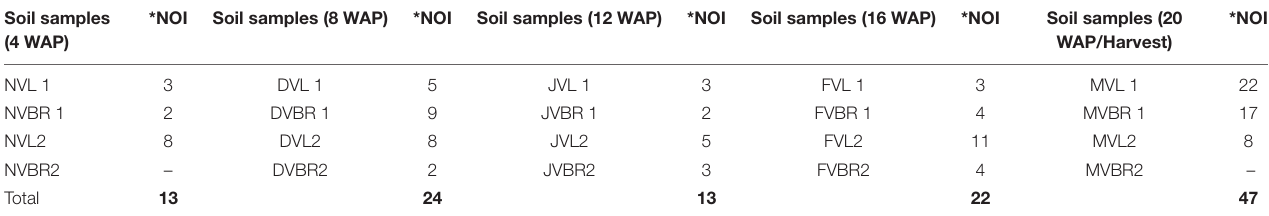
TABLE 1 | Total number of different isolates by morphology at different growth stages. Soil samples (4